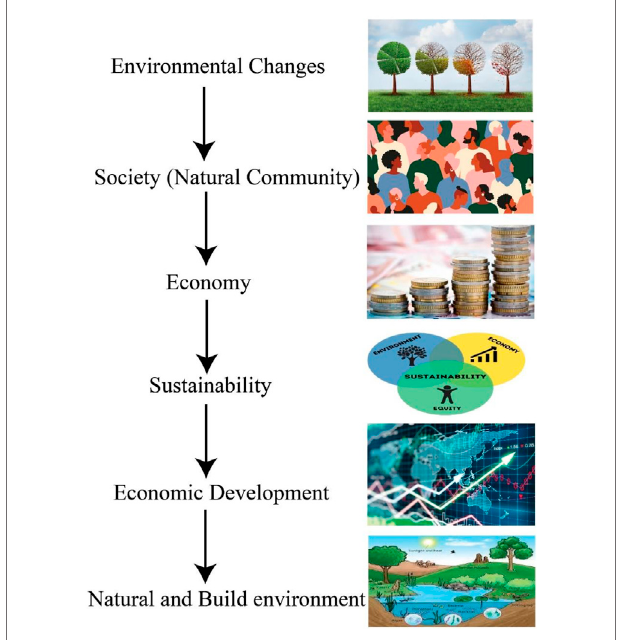
FIGURE 2 | Effect of environment on different parameters of life.